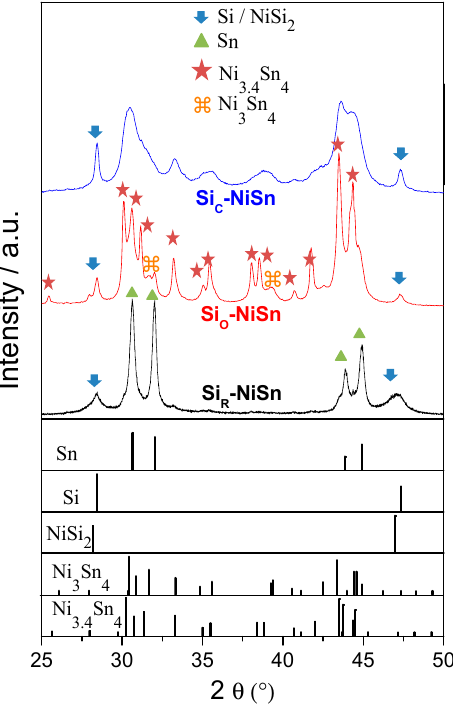
Figure 2. X-Ray Diffraction (XRD) patterns of the composites Si R -NiSn, Si C -NiSn and Si O -NiSn after 20 h of milling. Position of diffraction lines for Sn, Si, NiSi 2 , Ni 3 Sn 4 and Ni 3.4 Sn 4 phases as reported in Pearson’s crystal data base [40] are shown in the bottom part of the figure.